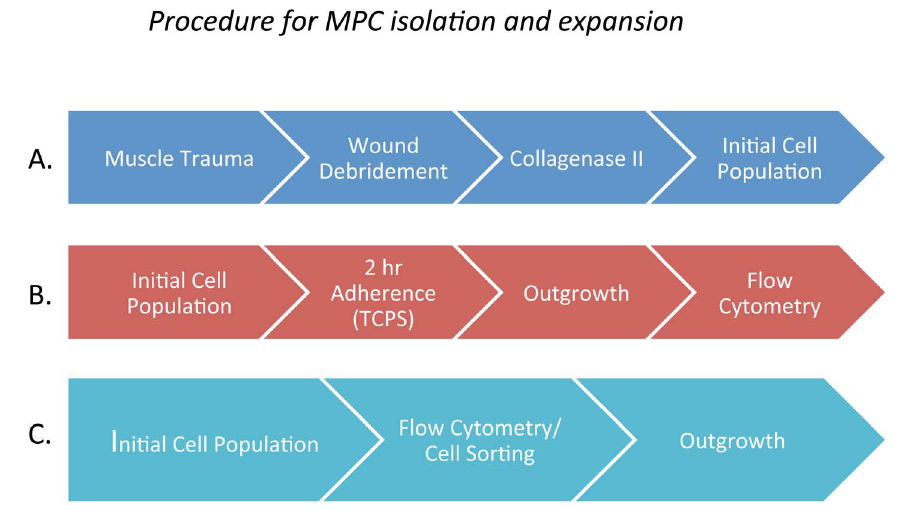
Fig. 1. Outline of the procedure for isolating progenitor cells from muscle. Figures 1A and 1B. Previously used procedure that entailed a 2 hour adherence to tissue culture polystyrene (TCPS) following by a 2 week (wk) outgrowth in tissue culture media followed by a flow cytometry analysis. Figures 1A and 1C. Procedure used in this study. A single cell suspension was used directly for flow cytometry analysis and cell sorting.